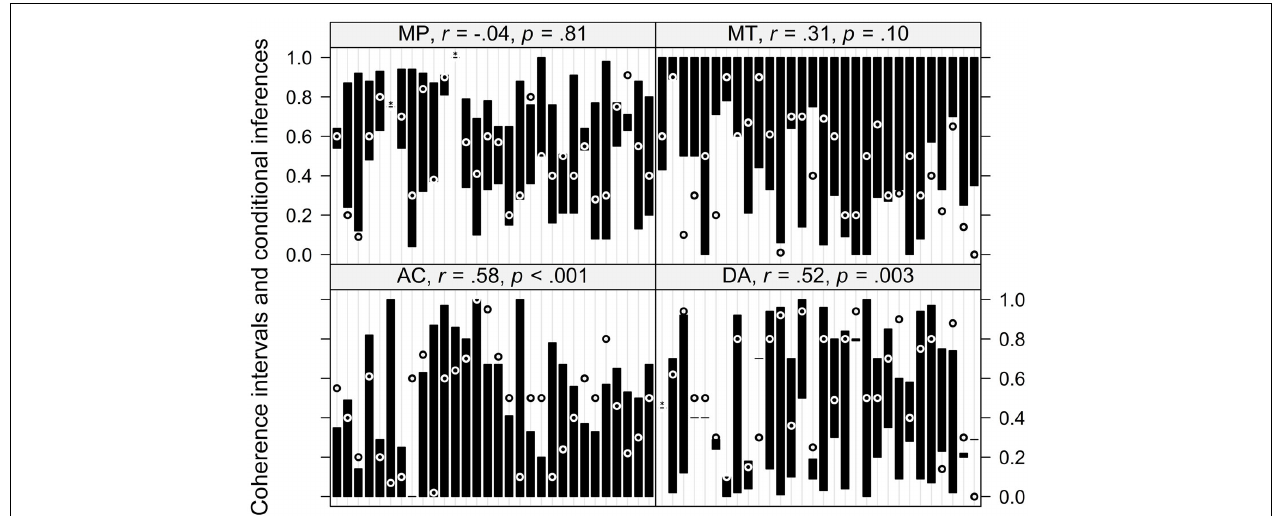
FIGURE 3 | Individual coherence intervals as predicted by mental probability logic and corresponding responses to the conditional inferences. The intervals are depicted by black bars, responses inside the interval are depicted as a white “ ◦ ,” responses outside the interval are depicted as a black “ ◦ .” Three cases in which the interval was only